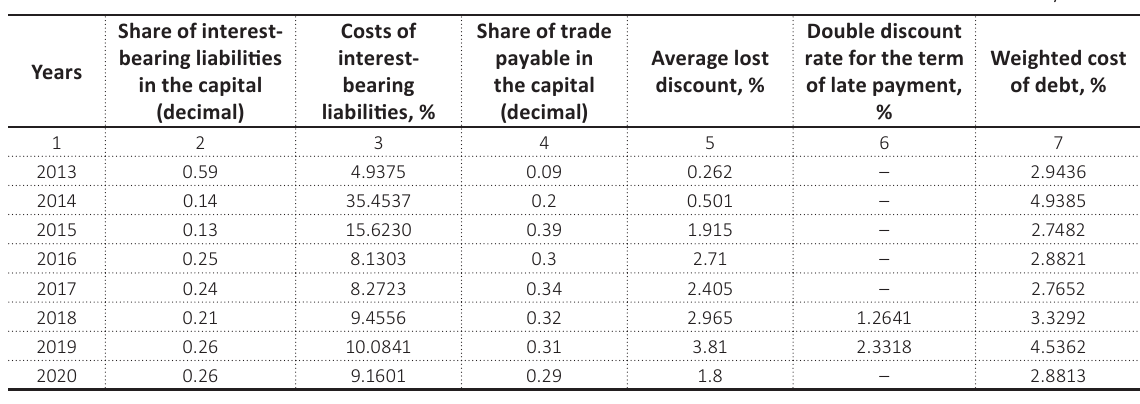
Table 6. Weighted cost of debt of